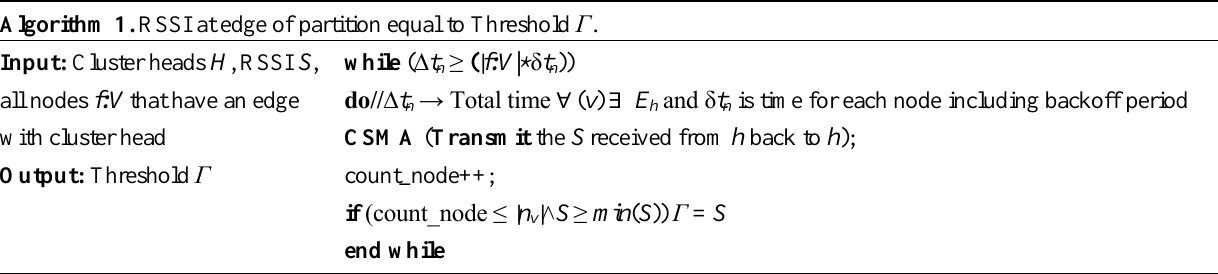
Table 1. Determination of Signal Strength of Edge nodes. Algorithm 1. RSSI at edge of partition equal to Threshold Γ